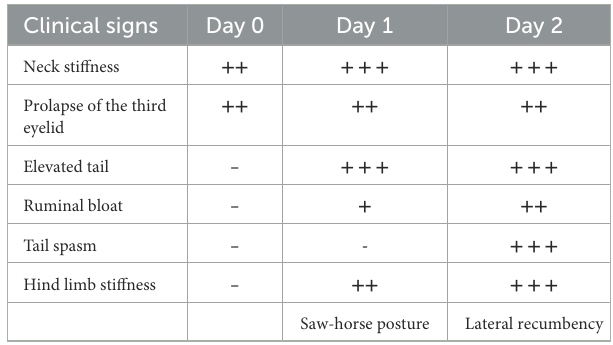
TABLE 1 Changes in the clinical symptoms observed for 3 days after the onset of tetanus